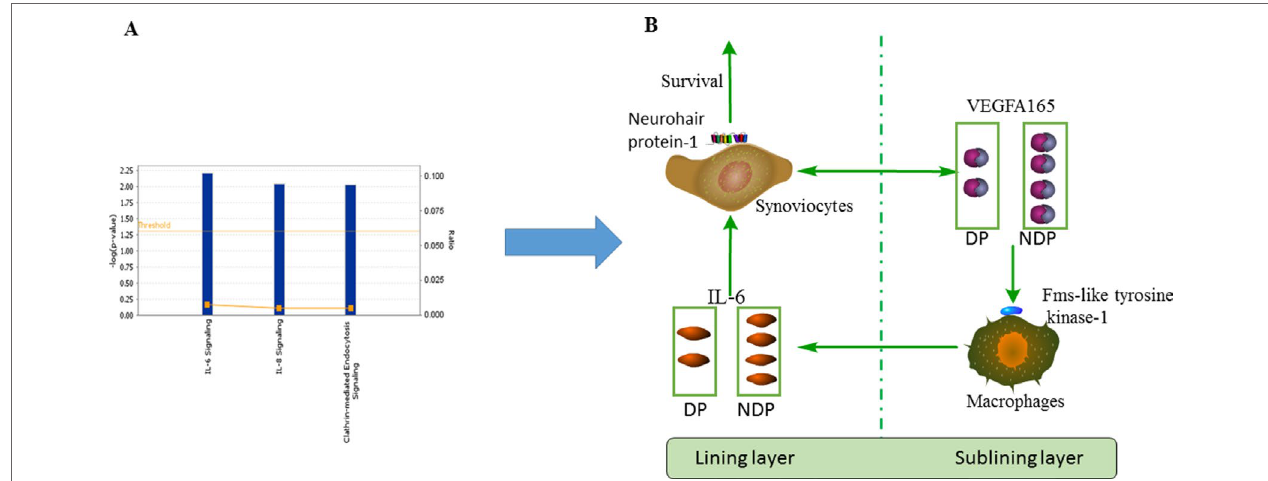
FIGURE 5 | Network analysis and schematic. (A) Three pathways related-VEGFA165 protein in RA, included IL-6 signaling, IL-8 signaling and clathrin-mediated endocytosis signling. (B) Schematic diagram of the role of VEGFA165 protein in